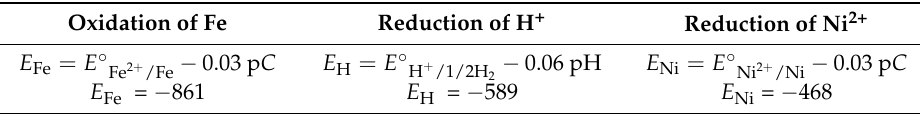
Table 2. Nernst potentials, E (mV/SCE).